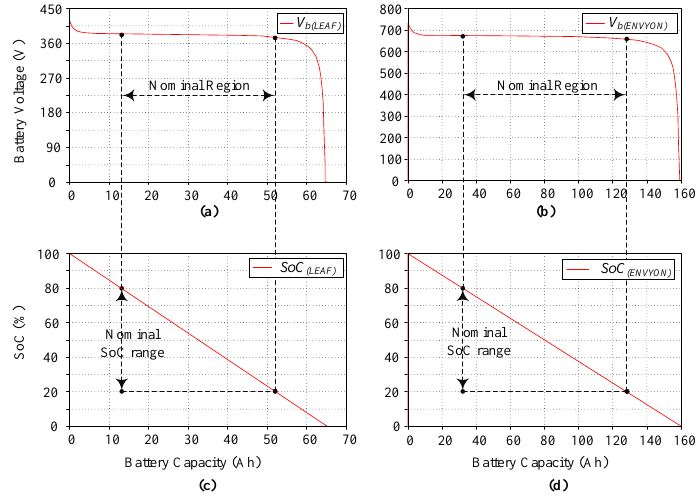
Figure 3. Battery discharge curves. ( a ) Discharge voltage characteristics of the Nissan LEAF battery. ( b ) Discharge voltage characteristics of the ENVYON battery. ( c ) SoC characteristics of the Nissan LEAF battery. ( d ) SoC characteristics of the ENVYON